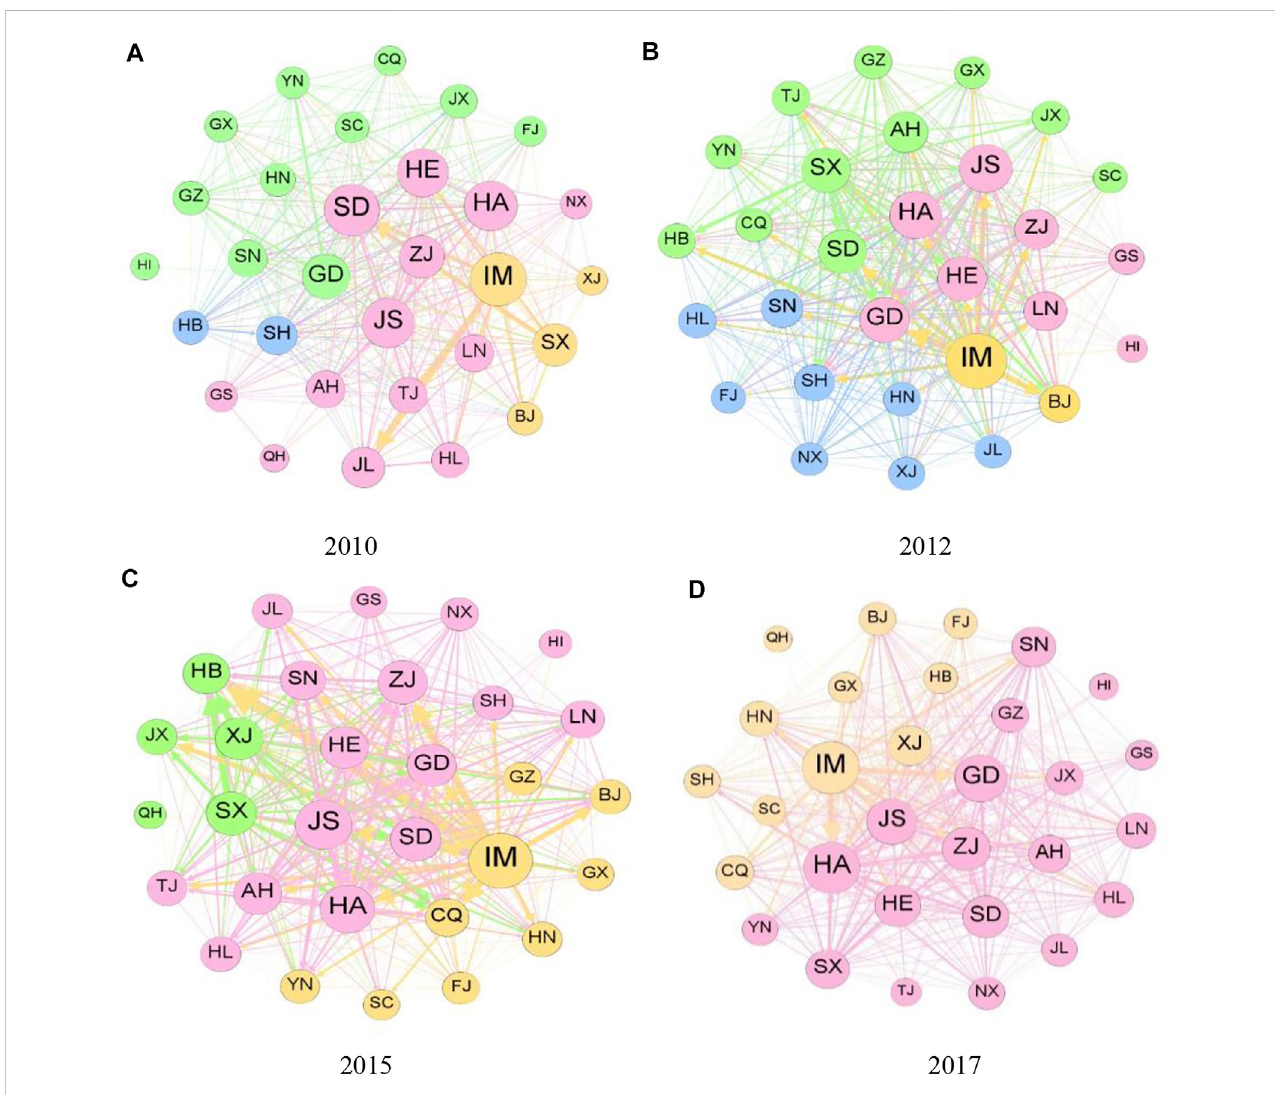
Communities of PECTNs in 2010 (A) , 2012 (B) , 2015 (C) and 2017 (D)